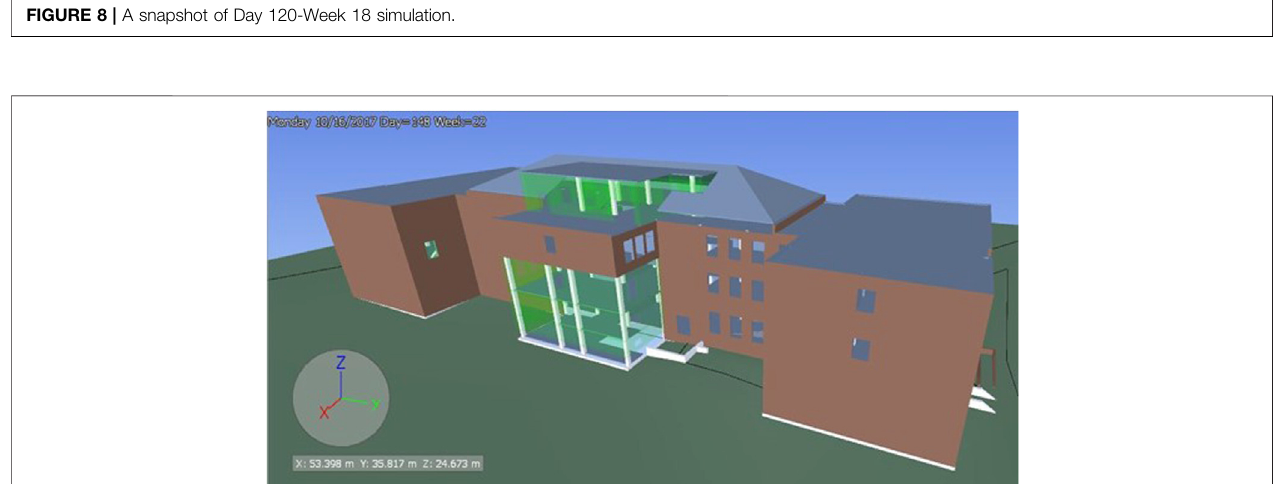
FIGURE 8 | A snapshot of Day 120-Week 18 simulation.